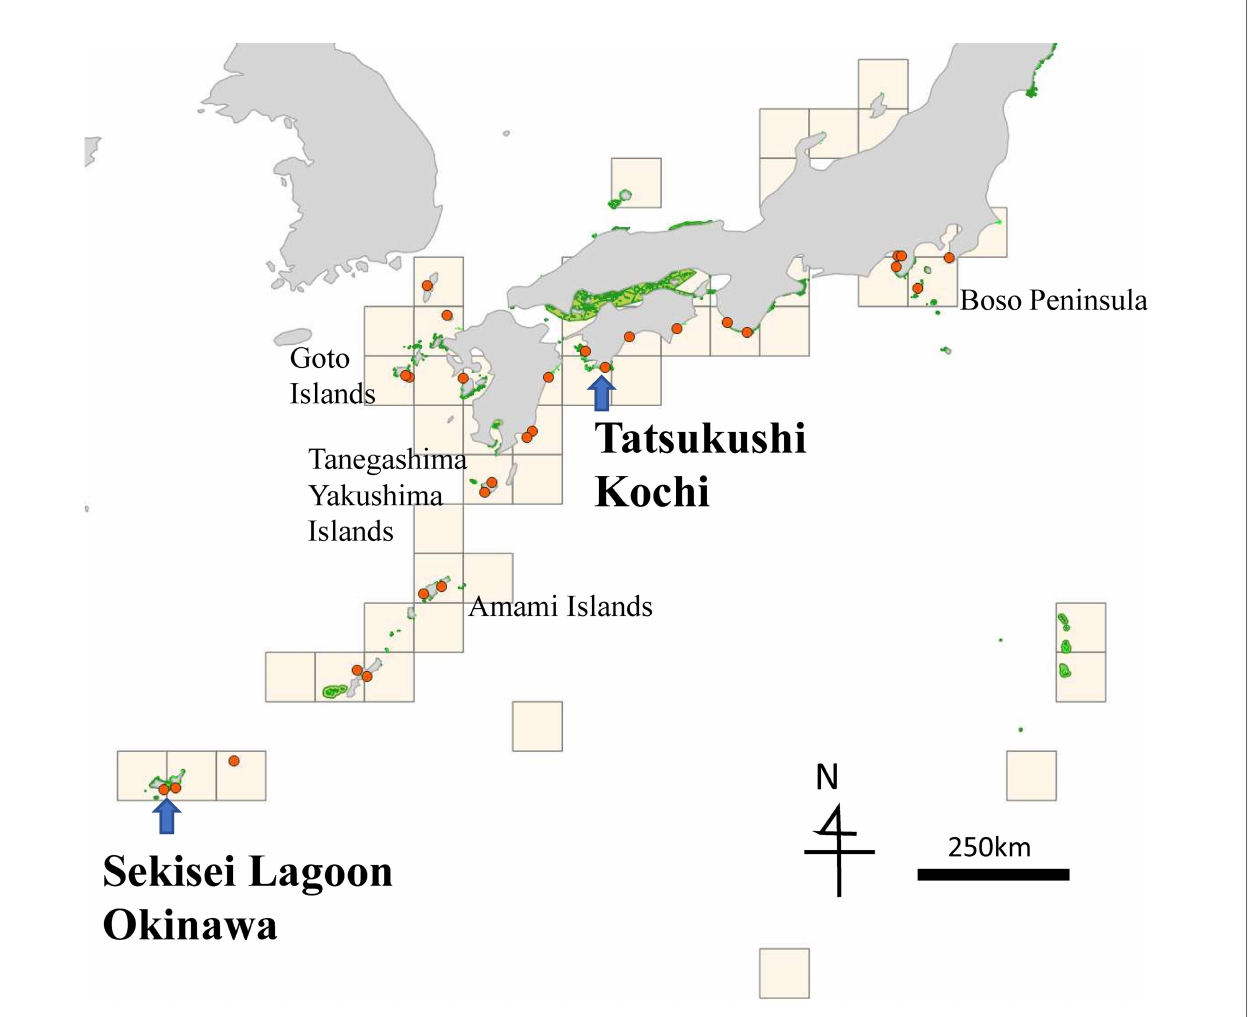
FIGURE 1 | Study site and grid. Dots, sampling locations; arrows, areas for restoration of coral reefs; green, national parks and marine